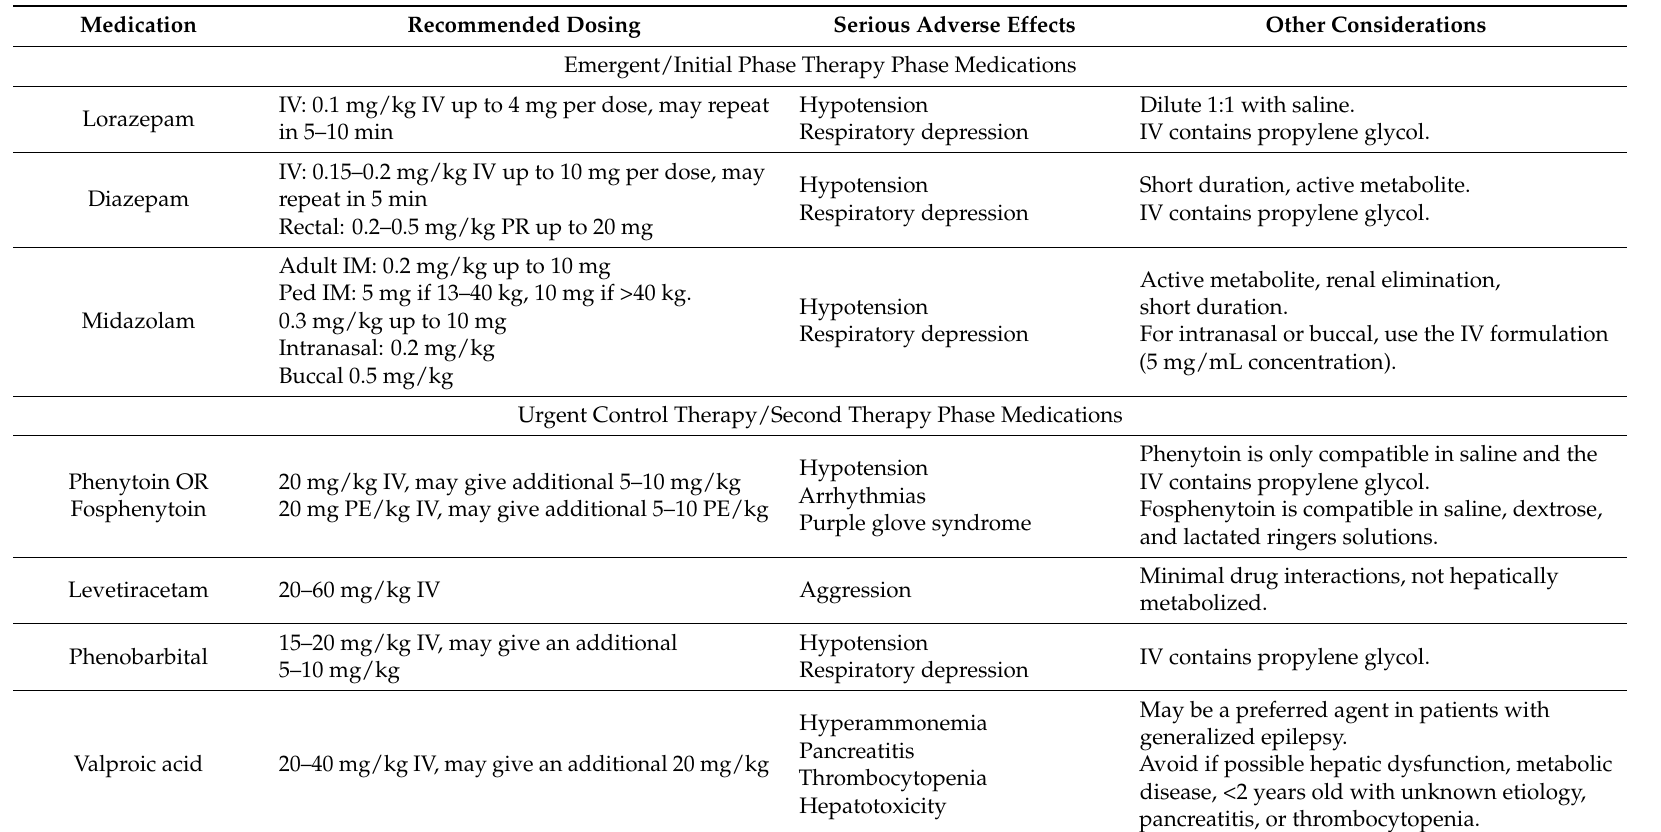
Table 2. Dosing recommendations and common side effects for emergent/initial-therapy-phase and urgent/second-therapy-phase anti-seizure medications. Adapted from the Neurocritical Care Society [7] and American Epilepsy Society [8] guidelines for status epilepticus